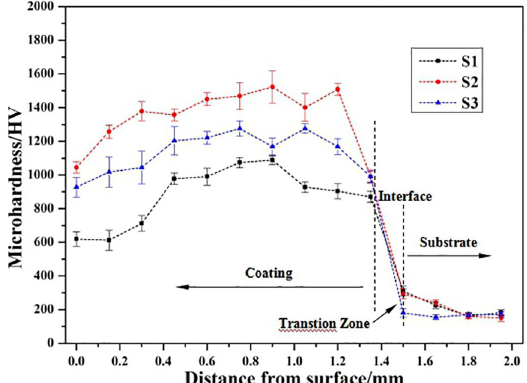
Figure 7. Microhardness profiles across the depth of the composite